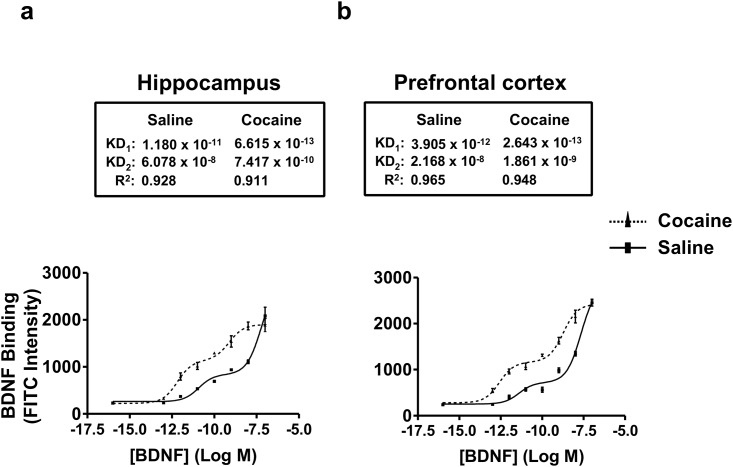
Prenatal cocaine exposure increased BDNF binding affinity for TrkB.Prenatal cocaine exposure increased BDNF binding affinity for TrkB by 18- and 15- fold (dotted lines) in biotinylated hippocampal and PFCX synaptic membranes, respectively from P21 prenatal cocaine- and saline-treated rats. In the control membranes, there were two BDNF binding sites, a high-affinity site (KD1) and a low-affinity site (KD2) (solid lines). Prenatal cocaine exposure also increased the low-affinity binding of BDNF by 82- and 12-fold. Nonlinear regression data curve fit was performed using Prism. Data points are the means and vertical bars are the s.e.m. derived from 6 independent rats (3 males and 3 females) in each treatment group.